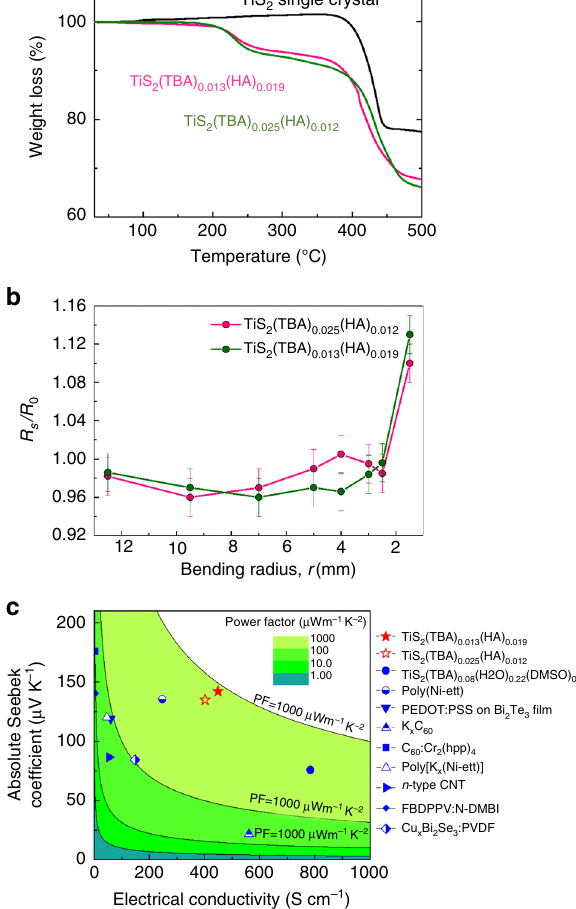
Fig. 5 a TG-DTA curve of TiS 2 single crystal, TiS 2 (TBA) 0.025 (HA) 0.012 and TiS 2 (TBA) 0.013 (HA) 0.019 . b The sheet resistance R as a function of bending radius for a TiS 2 (TBA) 0.025 (HA) 0.012 and TiS 2 (TBA) 0.013 (HA) 0.019 crystals, where R 0 is the corresponding value of its original state before